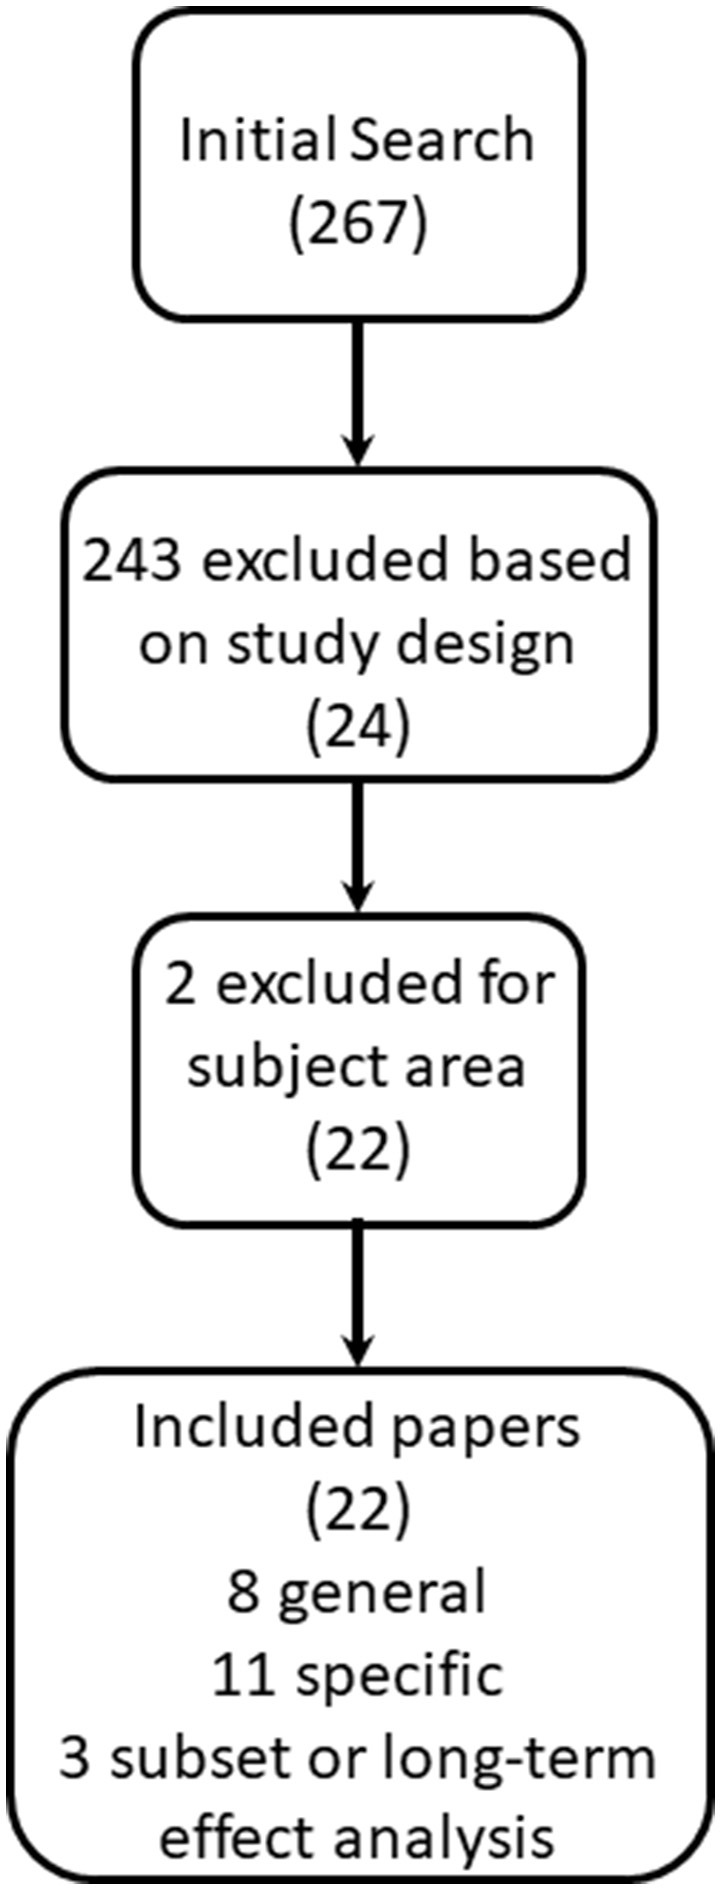
Inclusion flowchart.